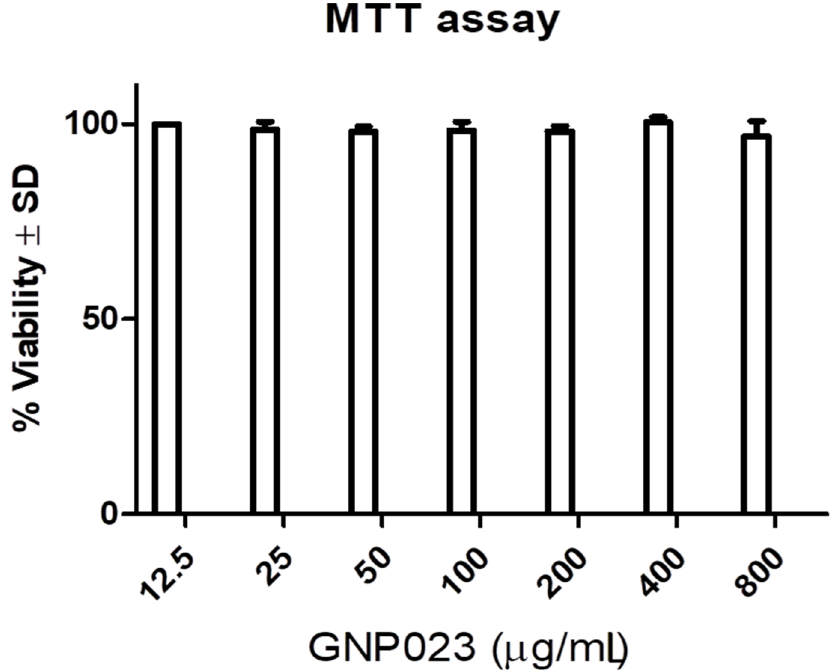
Figure 11. Effect of gold nanoparticle GNP023 on HEK 293 T normal cell line.